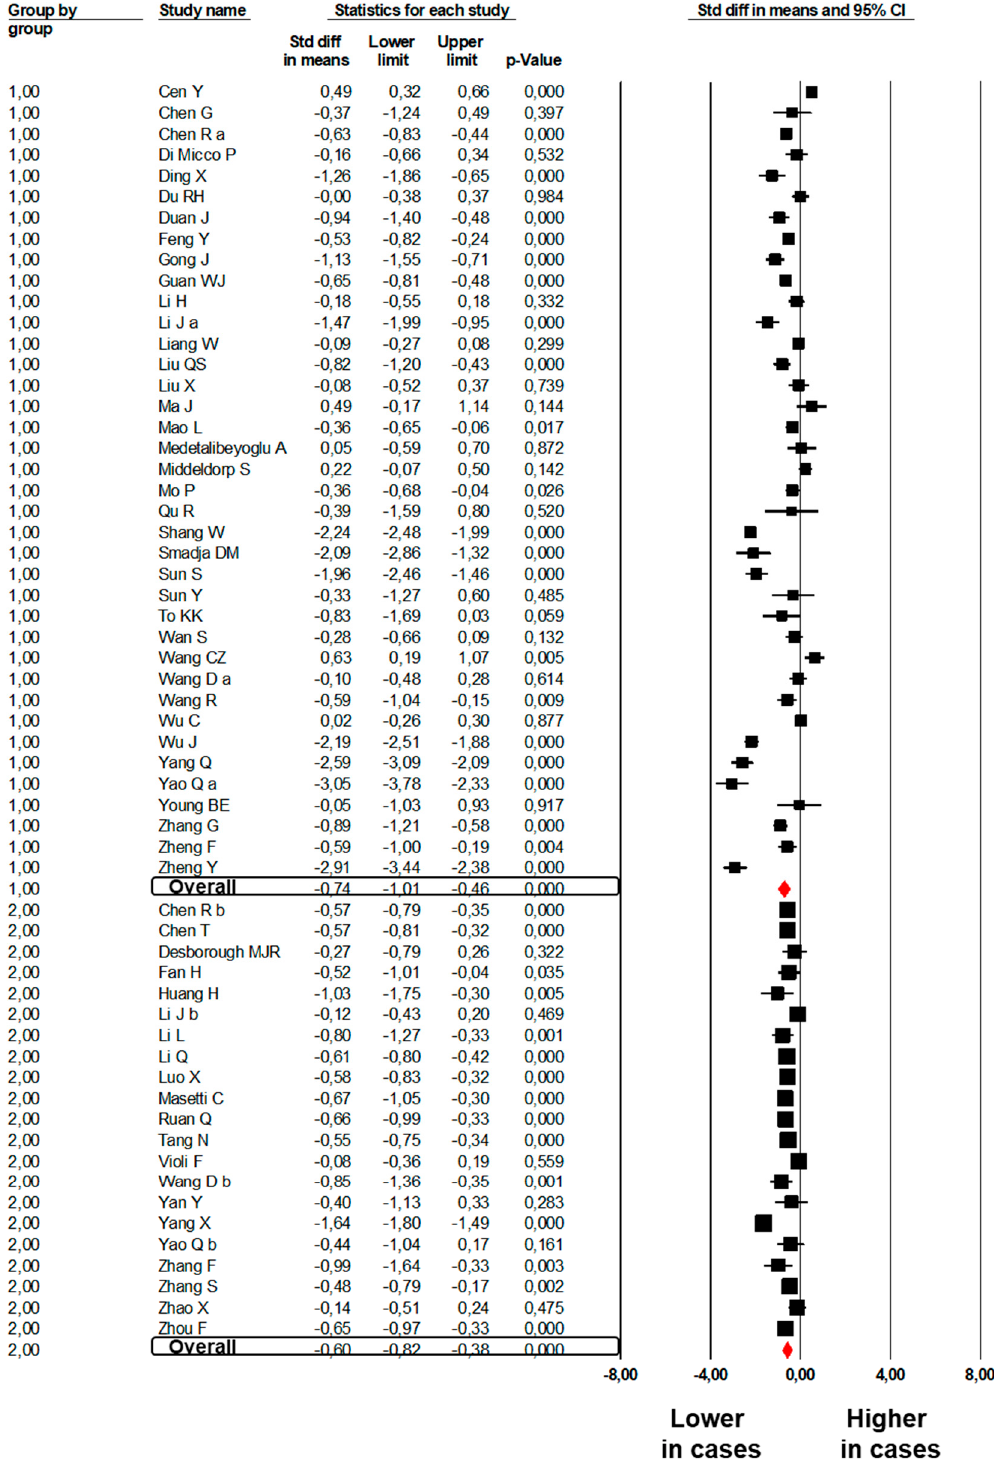
Figure 4. Forest plots of the difference in platelet count between subjects with severe and those with mild COVID-19 (Group 1) and between non-survivors and survivors to COVID-19 (Group 2).